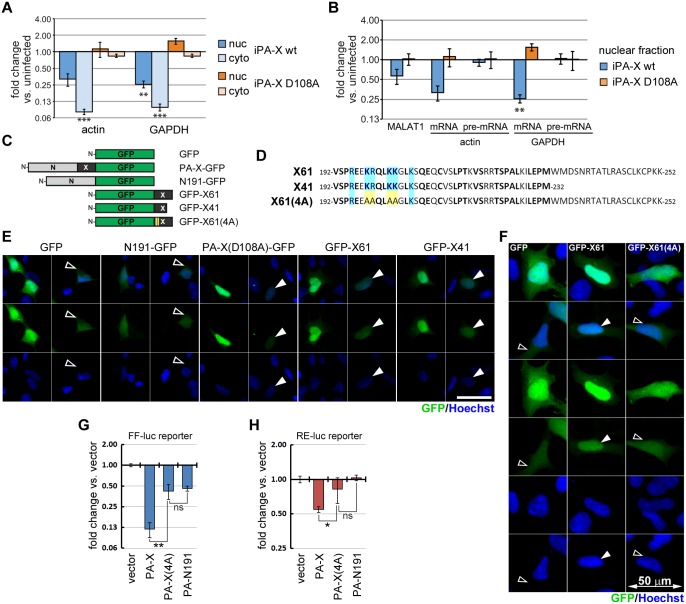
PA-X accumulates and functions in the cell nucleus.(A and B) A549 cells expressing doxycycline-inducible wild-type PA-X-myc (“iPA-X wt”, line #10) or a catalytically inactive mutant (“iPA-X D108A”, line #8) were treated with doxycycline for 18 h to induce expression of PA-X. Total RNA was isolated from either nuclear or cytoplasmic fraction and RT-qPCR was performed to measure levels of the indicated endogenous RNAs. RNA levels were normalized by 18S rRNA levels and are plotted as fold change in induced (PA-X-expressing) vs. uninduced cells. In (A), target level changes in nuclear (nuc) and cytoplasmic (cyto) fractions are presented. In (B), changes in total nuclear mRNA and in unspliced pre-mRNA are compared. Error bars = s.e.m, n = 3–4. (C) Schematic diagram of the GFP fusion constructs generated in this study. (D) Amino acid sequences of the X-ORF from PR8 strain (X61) aligned to a shortened 41 amino-acid construct (X41) and the mutant X-ORF with alanine substitutions at four basic residues (X61(4A)). Amino acids that are highly conserved between IAV strains are shown in bold and the basic residues that are important for PA-X function are highlighted in blue. (E and F) Fluorescence microscopy images of 293A cells transfected with the expression constructs for the indicated GFP fusion proteins listed in (C). Two fields of view are shown for each transfection experiment. Representative cells with nuclear GFP signal accumulation are highlighted with filled arrowheads and those that have even signal distribution with open arrowheads. Nuclei were stained with Hoechst dye. (G and H) Relative Firefly (FF-luc, G) and Renilla (RE-luc, H) luciferase reporter expression in 293A cells co-transfected with these reporters and the indicated wild-type and mutant PA-X constructs. Error bars = st. dev. from four independent biological replicates. *,** = p value < 0.05, 0.01 (**); ns = p value > 0.05 (Anova single factor).